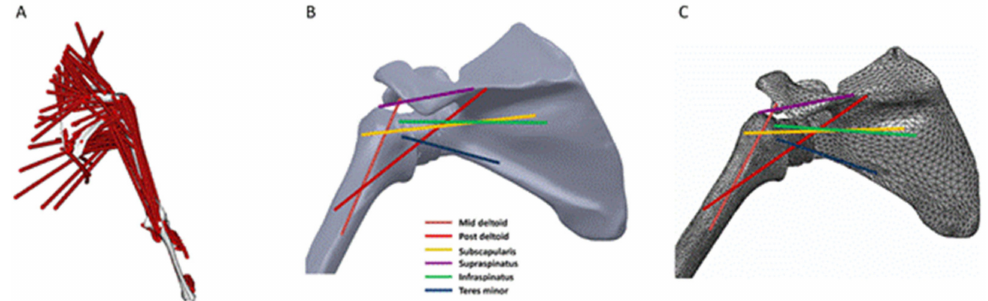
Figure 7. A multi-body model of the shoulder used to predict bone stress after RTSA [51]. Shown is the rigid body upper limb model ( A ), FE model with muscle lines of action ( B ), and the meshed FE model ( C